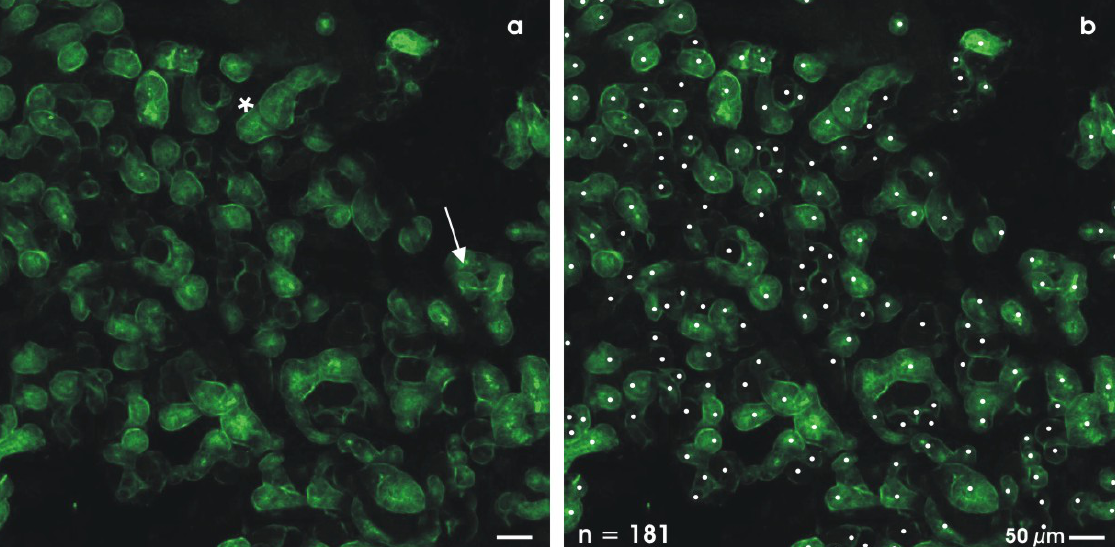
Figure 5. Generated renal tubules at the interface of an artificial polyester interstitium after 13 days of perfusion culture. (a) Fluorescence microscopy of whole mount specimens labeled by SBA. Tubules exhibit a lumen (arrow) and a basal lamina (asterisk). (b) Label reveals that in this specimen 181 tubules can be